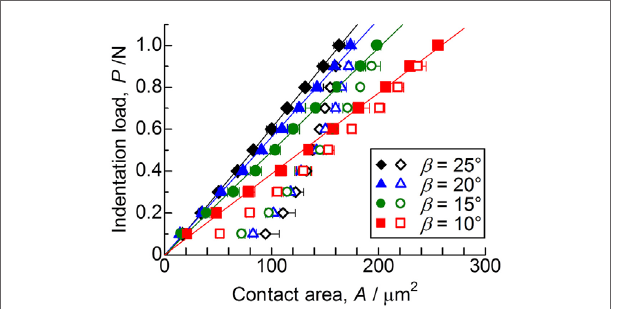
FigUre 4 | relations between the indentation load, P , and the in situ projected contact area, A c ( P – A c curves), during a single load–unload test of soda-lime glass using four different trigonal pyramid indenters with different face angles . The maximum indentation load is 1.0 N. Closed and open symbols represent the projected contact area during loading and unloading, respectively. Each P – A c curve was determined from at least six indentation tests using a given indenter. Error bars denote ± 1 SD. The solid lines are least square fits of the loading curves to linear functions.